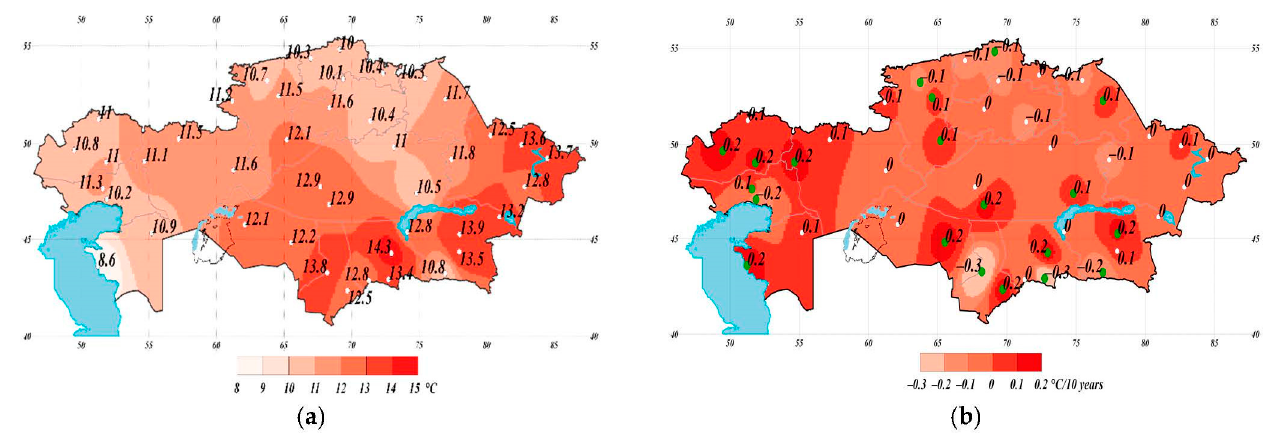
Figure 10. Spatial distribution of the daily temperature amplitude index (DTR) ( a ) and trends ( b ) of this parameter for the period 1971–2020.